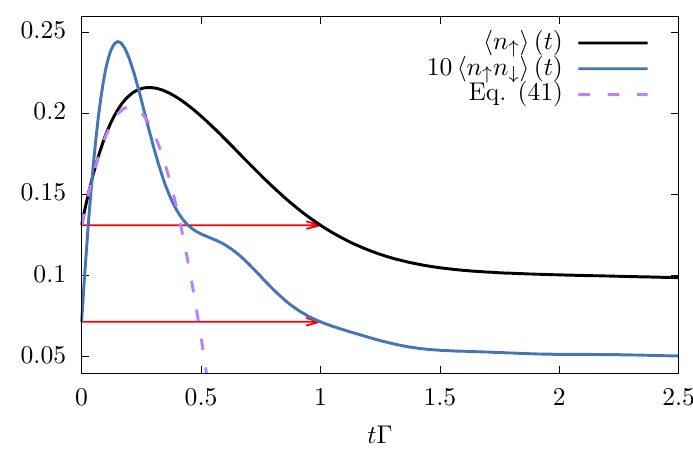
Figure 5: Reentrant effect for dot occupation and correlation for parameters U = 8 Γ , ε = 2.75 Γ , V = Γ at T = 0. The reentrant effect for time t